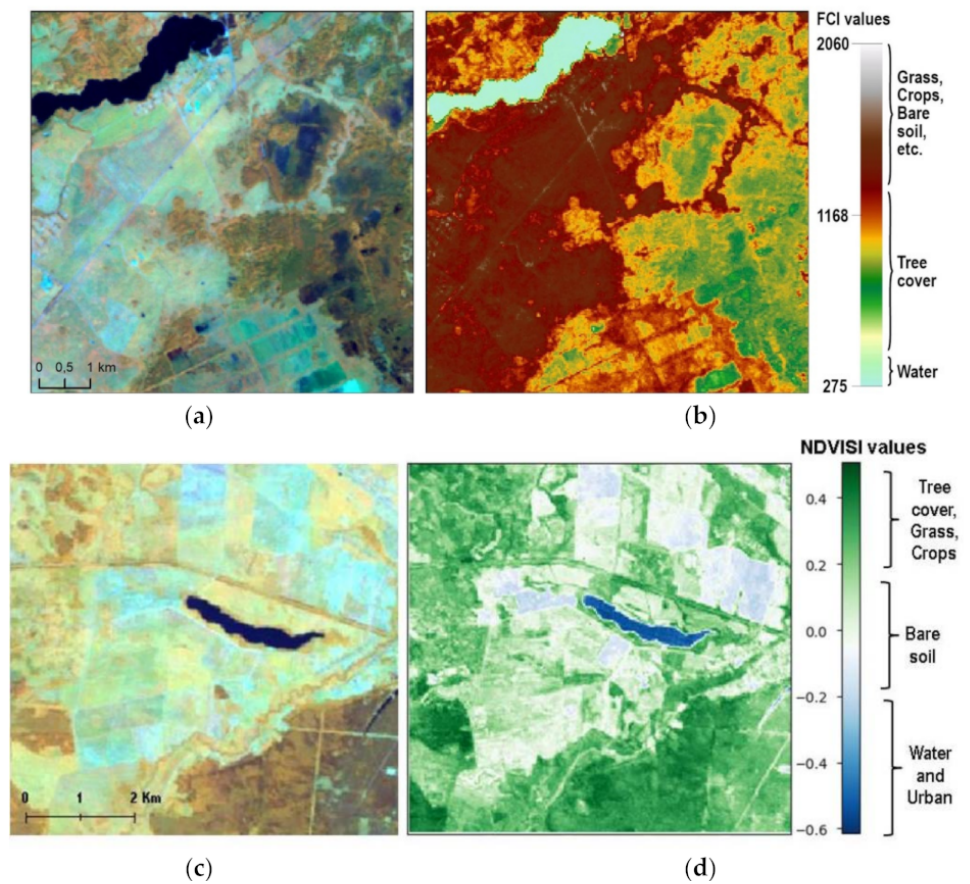
Figure 3. Fragments of the 2006–2010 ( a , c ) five-year mosaics (NIR-SWIR1-Red synthesis) over the study area and respective FCI ( b ) and the NDVISI values ( d